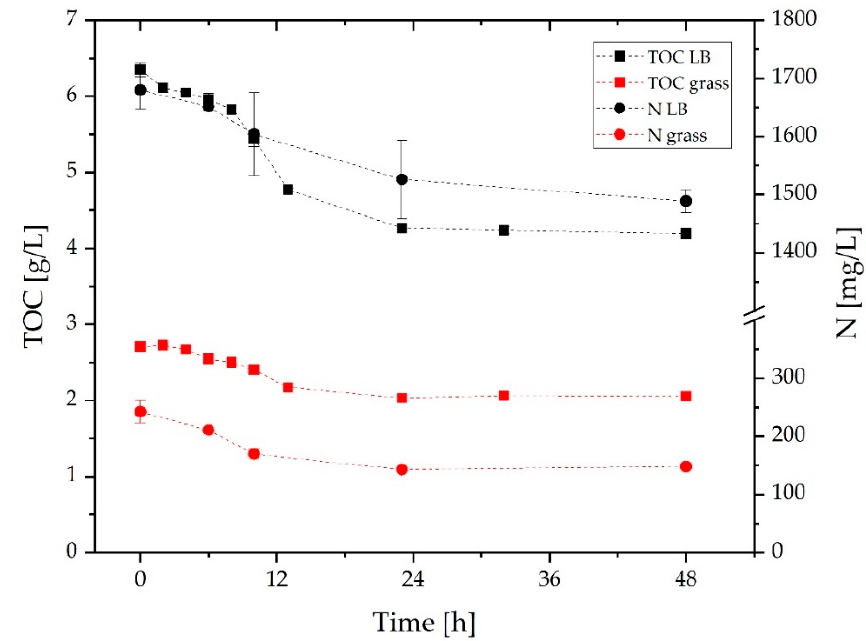
Figure 5. The concentration of TOC and N during the cultivation of C. necator pKR-hum in LB medium and grass medium ( n = 3, dashed line serves as a guide to the eye ).